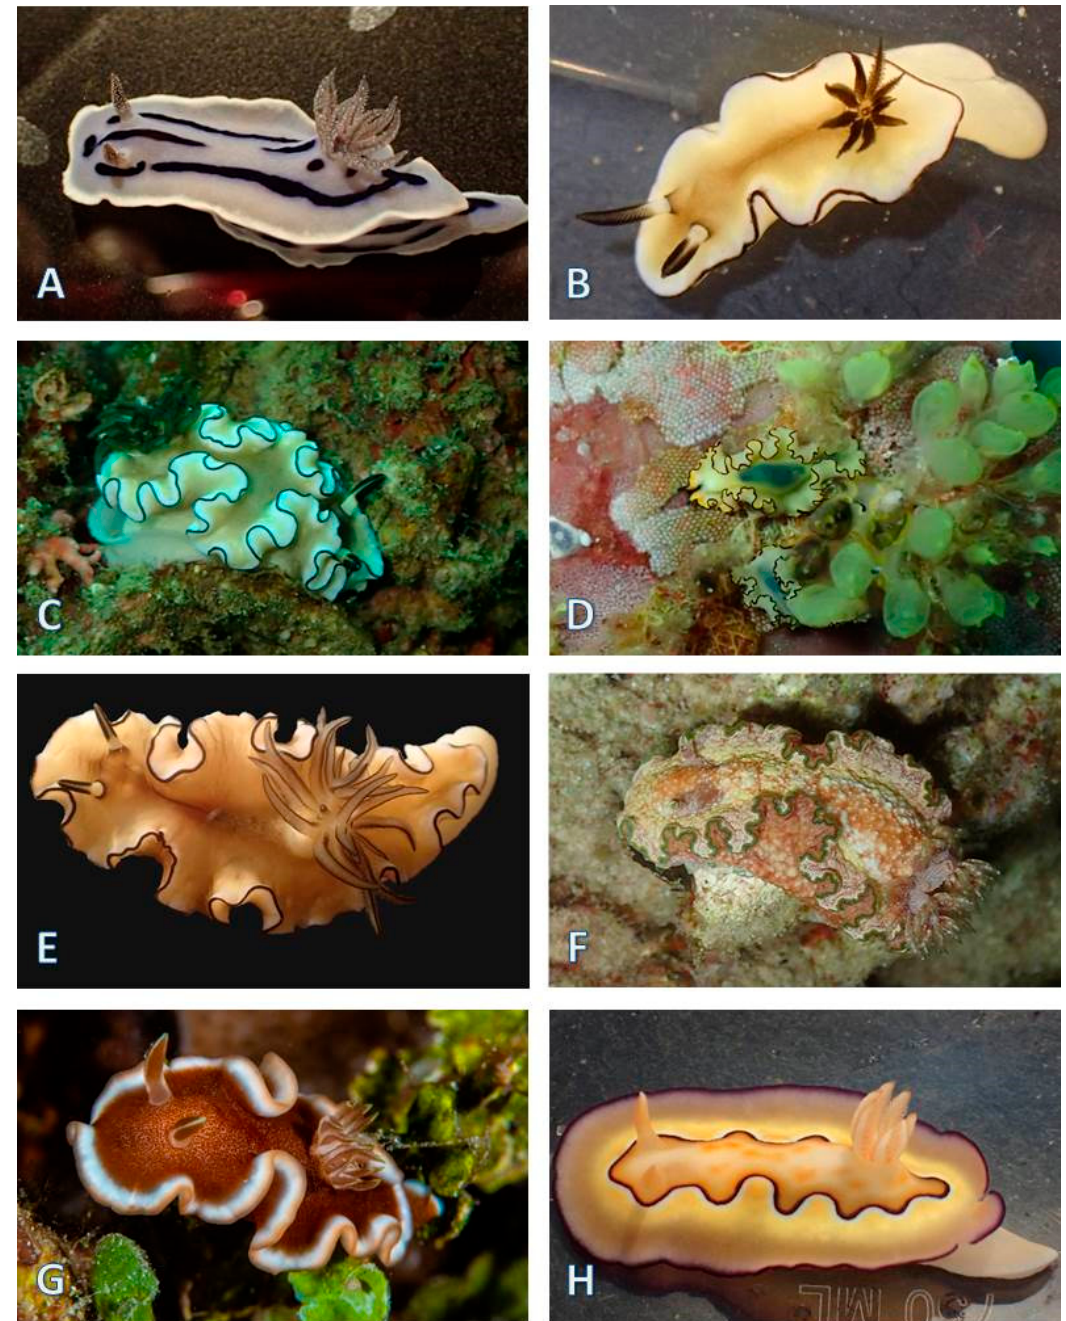
Figure 12. Nudibranchia Doridina: ( A ) Chromodoris willani , Chwi18Ba-1; ( B ) Doriprismatica atromarginata , Doat17Ba-1; ( C ) Doriprismatica atromarginata in situ; ( D ) Flatworm mimicking D. atromarginata ; ( E ) Doriprismatica sibogae , Dosi17Ba-1; ( F ) Glossodoris cincta , Glci18Ba-1; ( G ) Glossodoris rufomarginata *; ( H ) Goniobranchus coi , Gocho17Ba-1. *Specimen not collected.